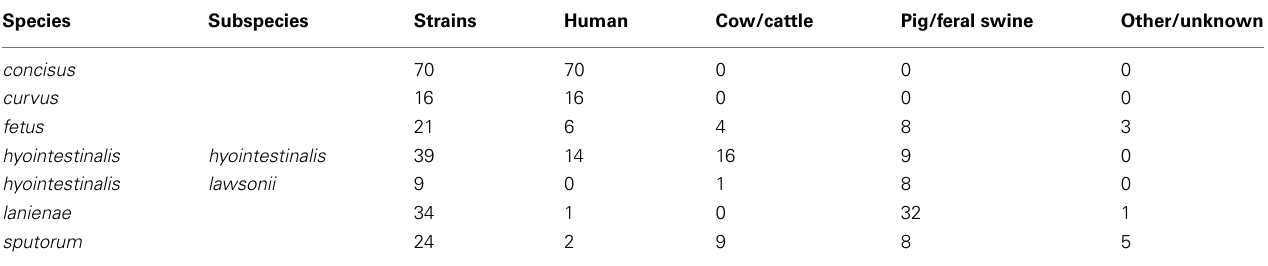
at only one of the seven MLST loci. For example, Chh STs con- Figure 2 ) were divergent at only the pgm locus. The alleles for each of the remaining six loci within each ST were of likely Chh origin, and phylogenetic analysis of the concatenated allele sequences clearly placed these two STs within the Chh clade. How-